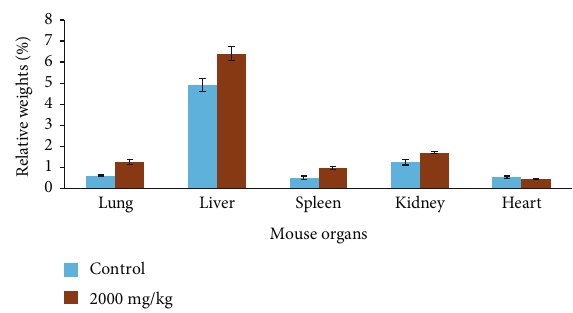
Figure 3: Evolution of mouse relative organ weight following treatment with Tm sb w . Bars represent means ± SD , n = 5 .